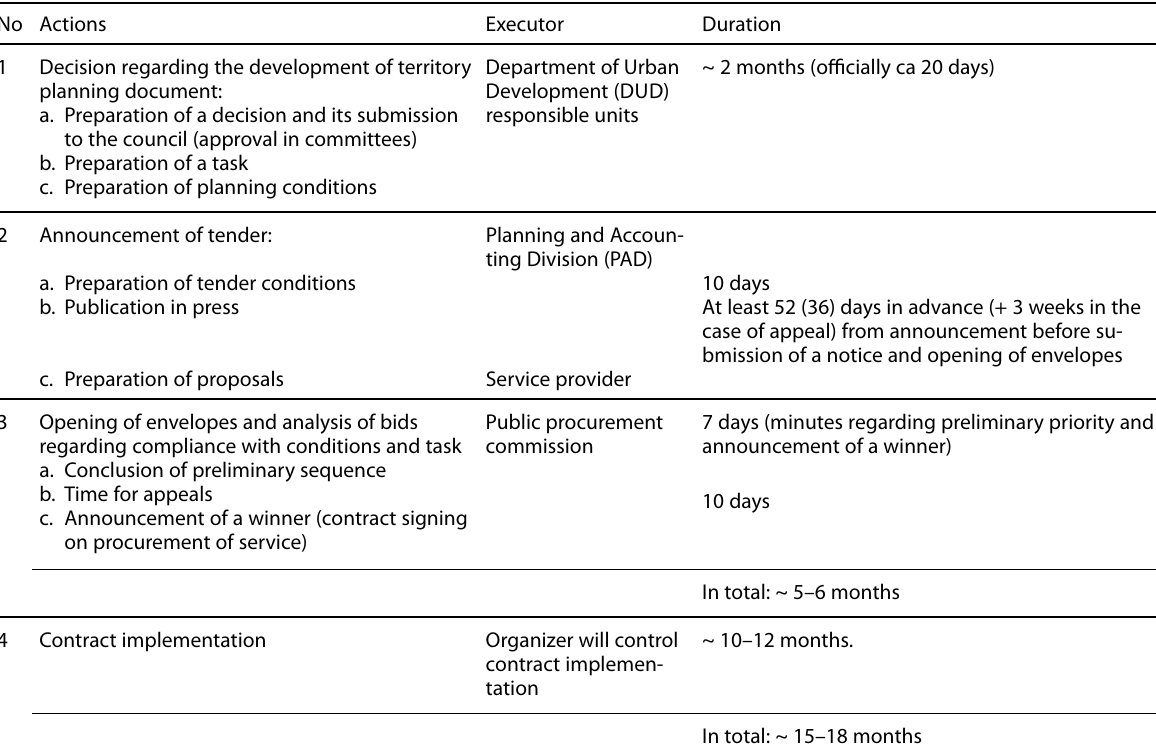
Table 1. Analysis of duration of organising public procurement of services to prepare territory planning, urban projects accor- ding to the Law Amending the Law on Public Procurement of the r­epublic of Lithuania